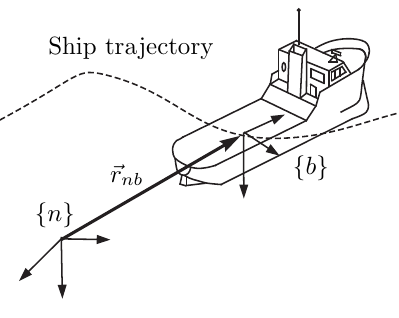
Figure 3: Ship position used in